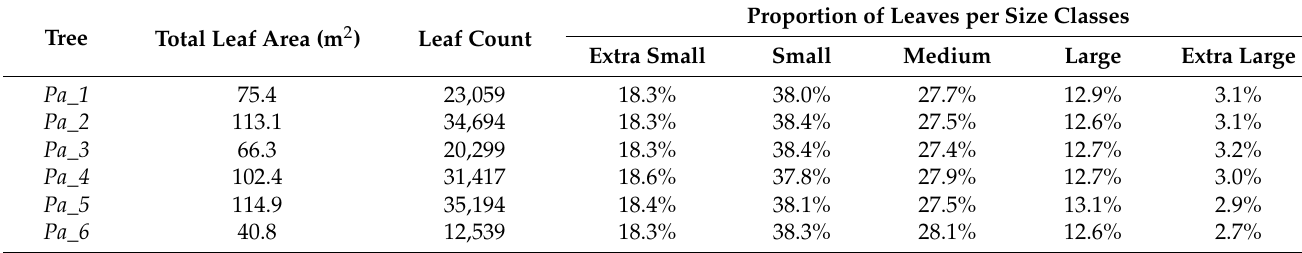
Table 3. Total leaf area, leaf count and proportion of realistic leaves in each size class. Leaves created with the Leaf Creation Algorithm (LCA), with leaf spacing of 2 cm, for each wild cherry tree ( Pa_1 to Pa_6 ). Tree Total Leaf Area (m 2